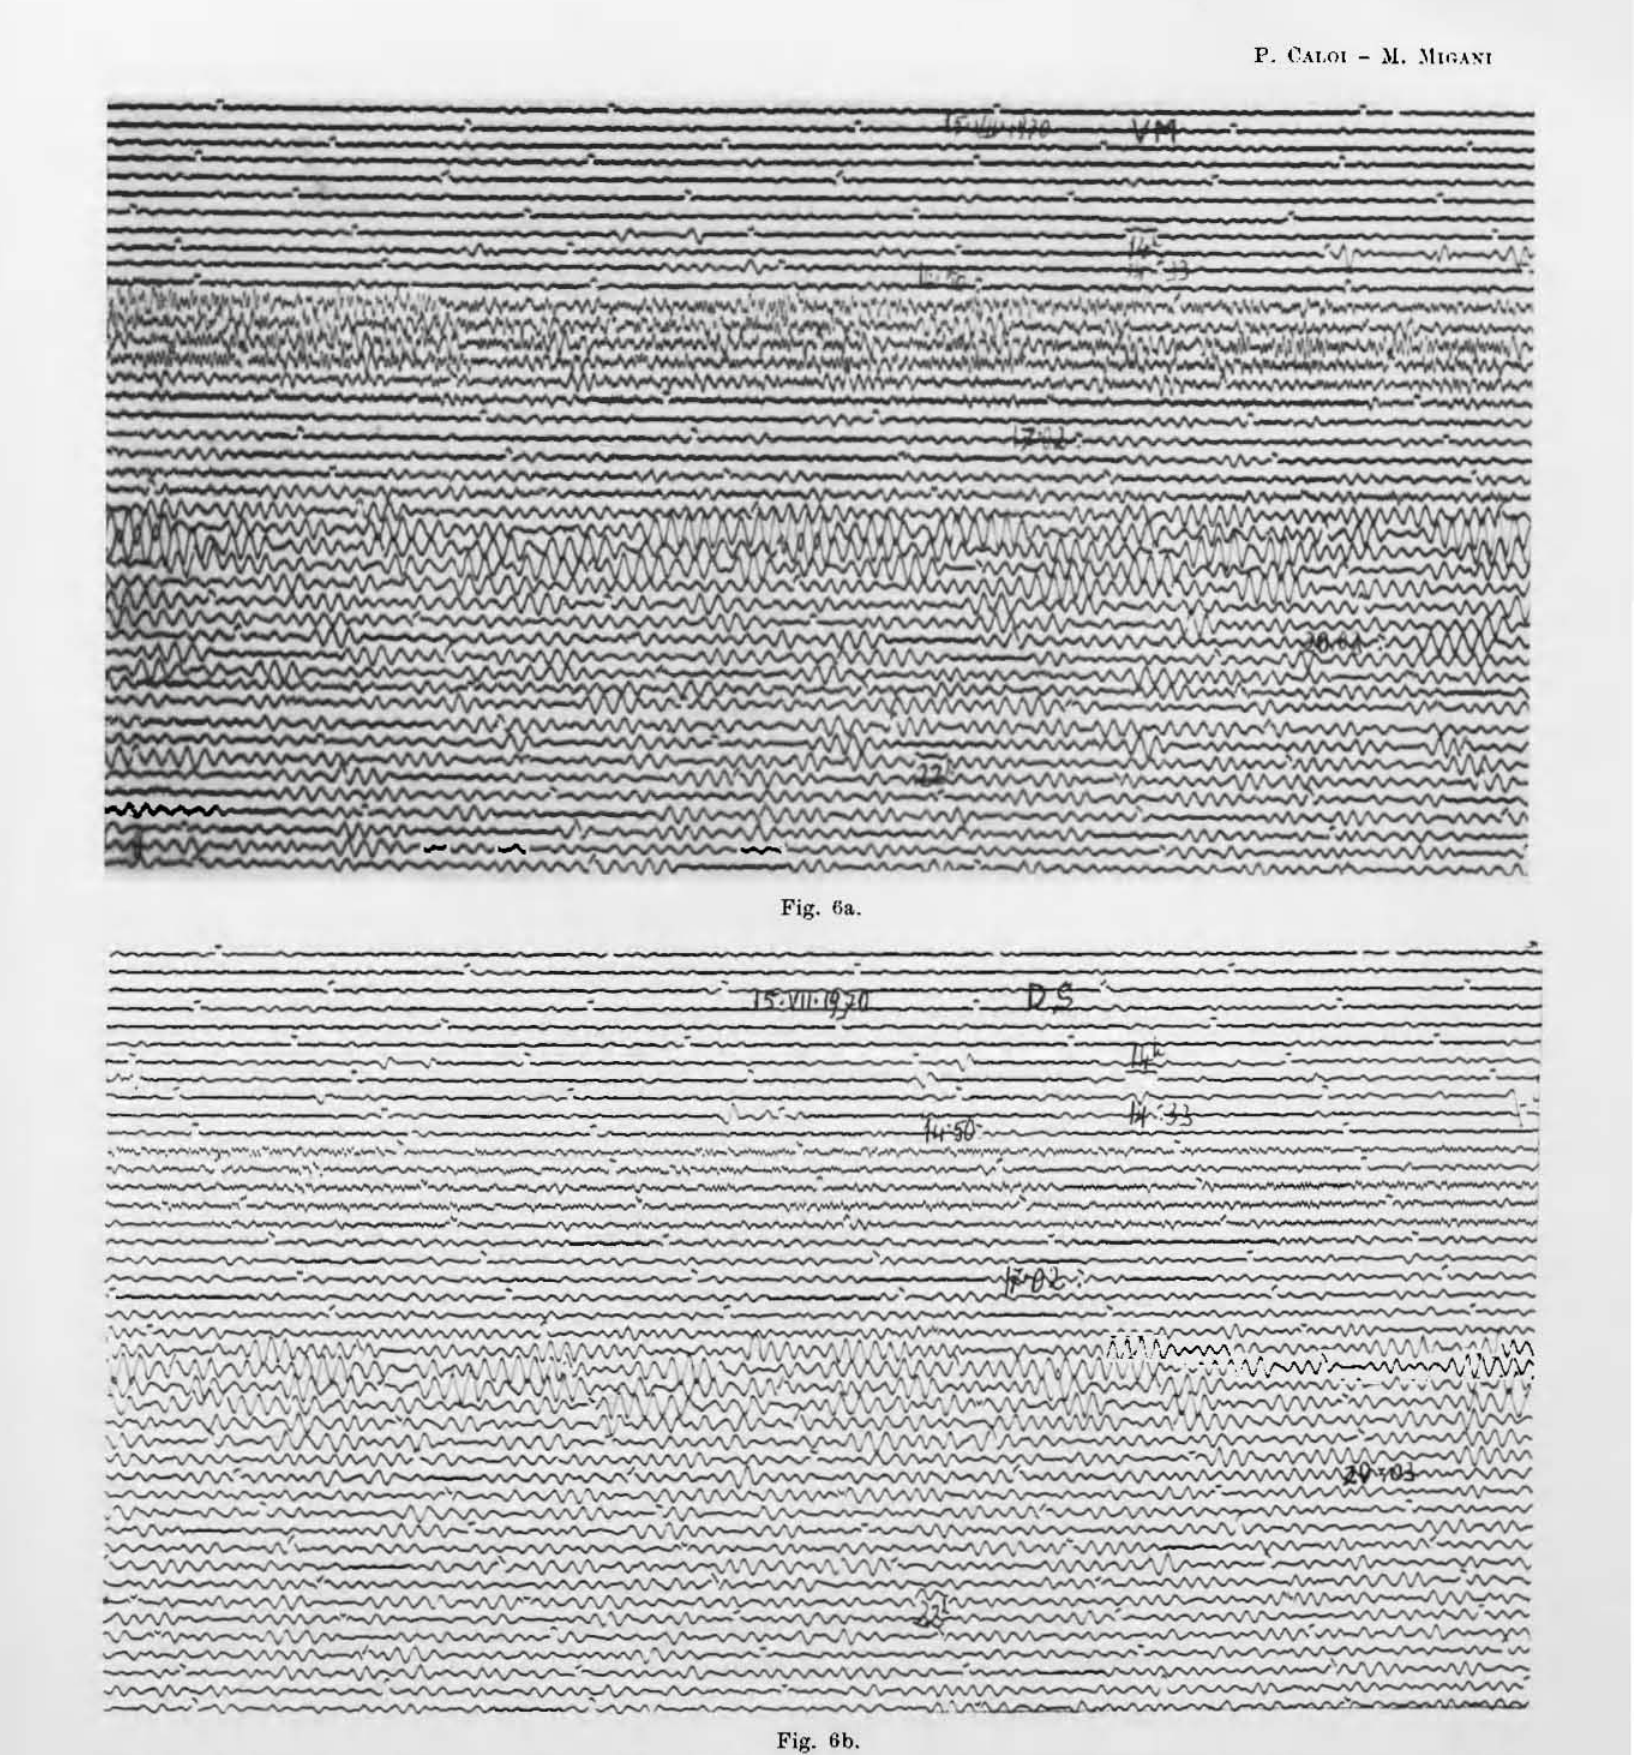
Fig. 6 - R~onlings or micrOliOismic lOovememts, obtained at Pieve Ili Cadore. on tbe lake or the same na.me. a.&6ociated with the Pasuge of the cyclono of July l!i, 1970. Two separate ph311611 may beobs"rved, tbe lirst frolO 2l'4(1mp.m. (Mean Solar Time) to 4"5(1<11 p.lO. ApproxilO~tely, tb6 !i6Con,1 fronl 5b3c}<:> p.m. on wa.nl. The first phMe, which is of moro intorest as it conl.ainll th6 new fact, is formed by microseismll provokoo by tho ptUls4!Jr 01 the cycloru culre direelt.1i over ll.e lale al> a consoquonce of tll0 interaction be· twoon the turblliance of the atlOospheric pressuro in tho pOllitivo phue, and the utltlerlying lako wator which giv6$ rise 10 rapi,] lOicroeeielos with period@ generally lower than ono s6Cond. The 56<\on,1 ph~ le linked, however, te the pass&ge ol the centro of the salOe cyclolle over the GuU of Venice. As is the case al!lO with the other ob!!orvation statiOllS (fig. 19·25), the ma.xima. of mÌl.:roseillm8 comillg from the Atlriatic region occur at Pieve Ili Ca(lore beginning aL about 6h30n> p.m., whell the cyclone paSil68 over the Gulf 01 Trieste, at a tllstance ol some 125 kms trolO Pieve (li Cadore. The mean perio(1 microseislOS oI tbia secoml storm (the seeolld for Pieve) 18 about 2-,6, as with tbe otber seismic